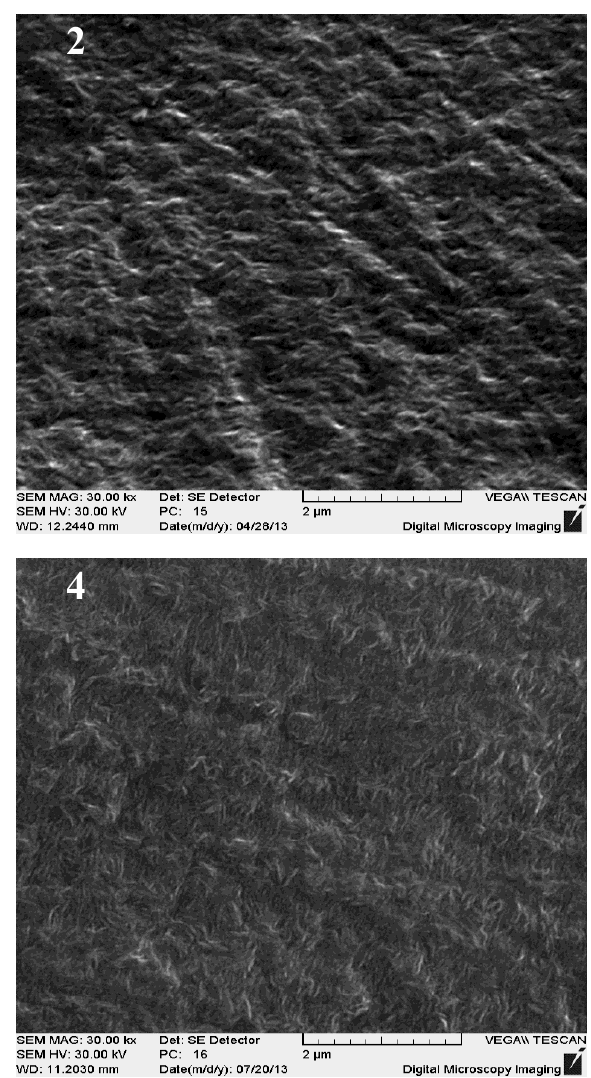
Figure 1. Scanning electron microscope (SEM) micrographs of untreated and modified substrates (samples 1–8) taken at 30,000×